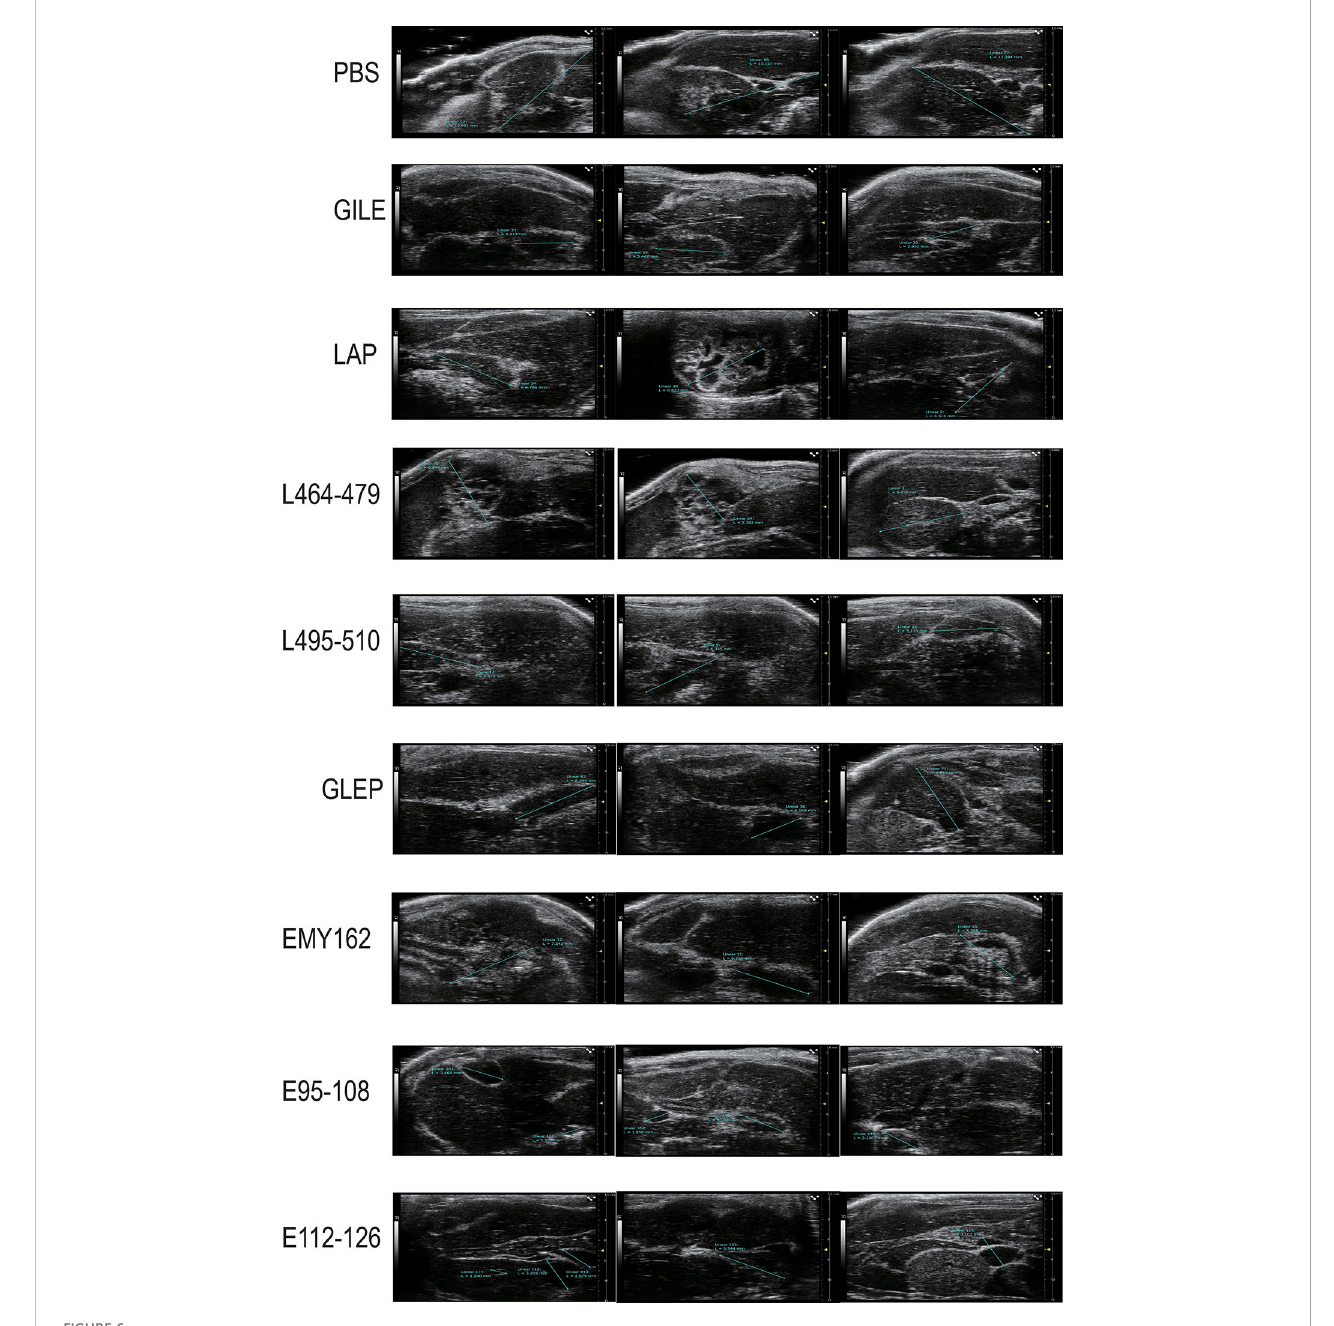
FIGURE 6 Detection of every challenge experiment mouse (PBS group and Vaccine groups) enterocoelia and liver cyst size by